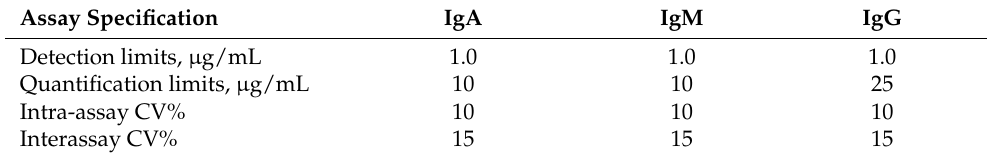
Table 3. Immunoglobulin (Ig) assay specifications according to the ELISA kit